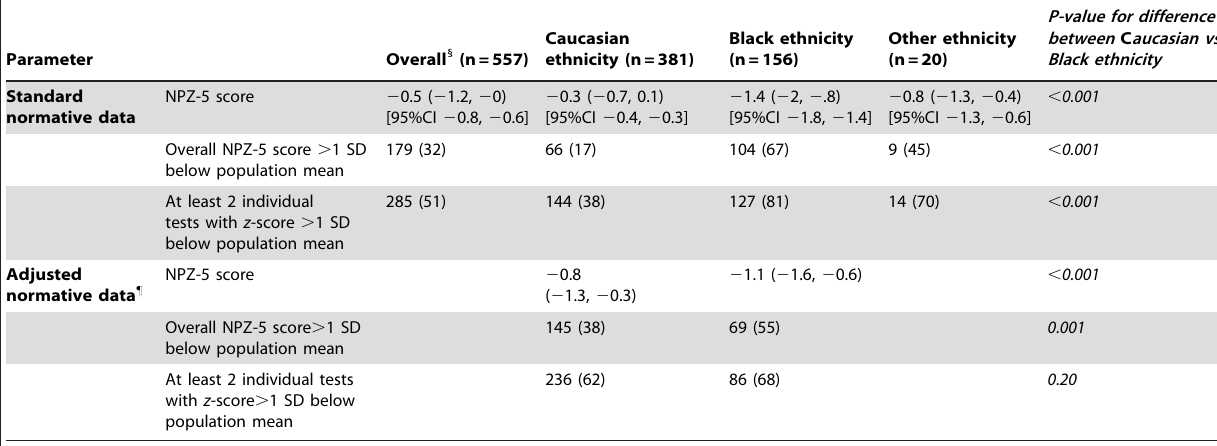
Table 2 legend : 1 patients with complete neurocognitive data including patients of ethnicity other than Caucasian or Black (n=20); IQR = interquartile range, SD = standard deviation; " Excludes all patients of ethnicity other than Caucasian and Black, as well as 30 subjects of Black ethnicity who fell outside the age range covered by the adjusted normative data; NPZ-5 results using standard normative data in these 30 patients were similar to those of the other 126 patients. Data are number (%) or median (interquartile range).